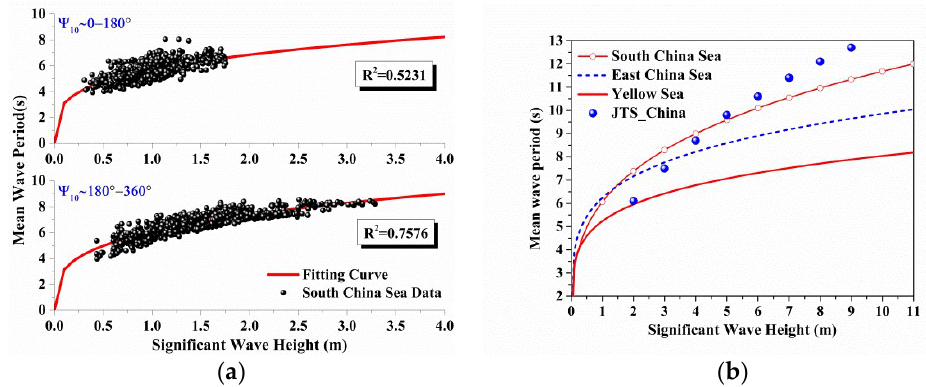
Figure 5. ( a ) The comparison between the scattered data (data points) based on wind direction and empirical formulas (line) versus significant wave height in the South China Sea. ( b ) Detailed comparison of the empirical formulas for China offshore seas with the approximate relation in literature [21].